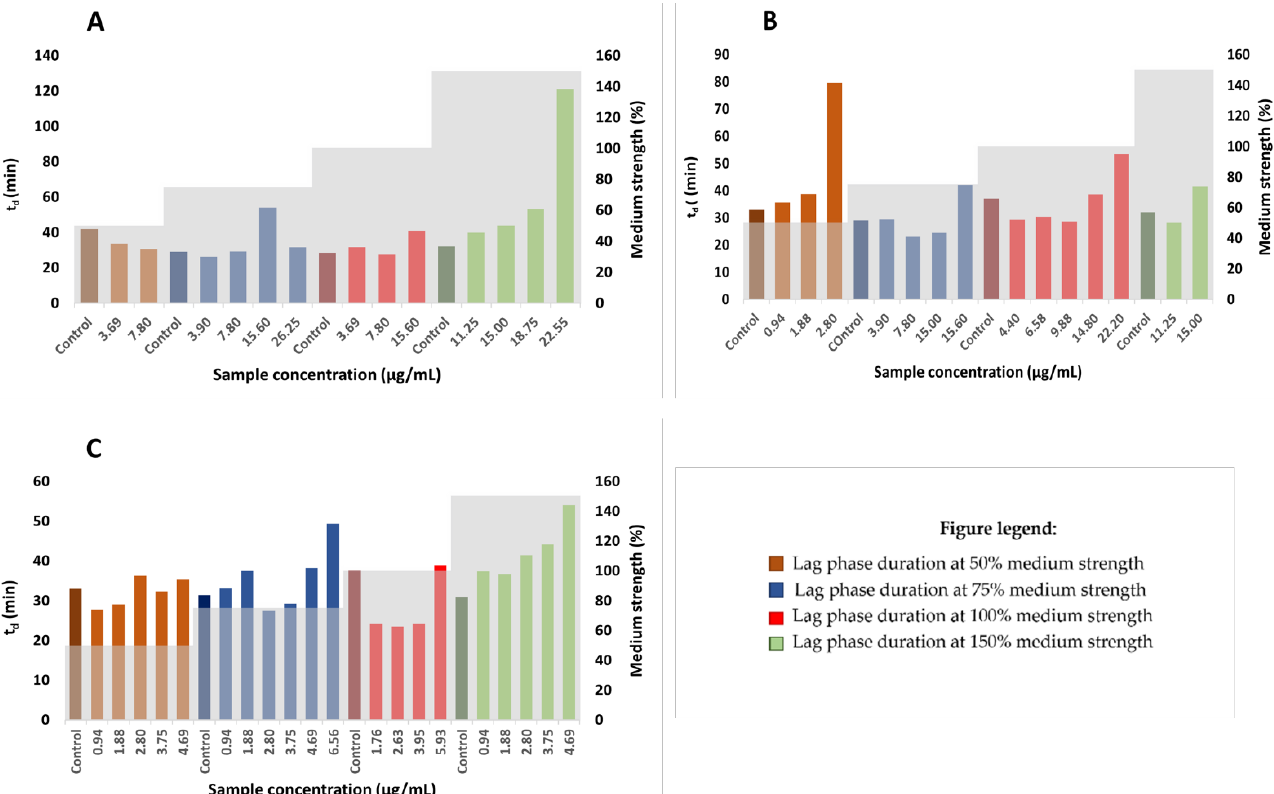
Figure 3. The effect of different concentrations of hop extracts on the lag phase duration of Staphylo- coccus aureus ; ( A ) HAE Styrian Eagle, ( B ) αβ -AF extract, ( C ) β -AF extract.